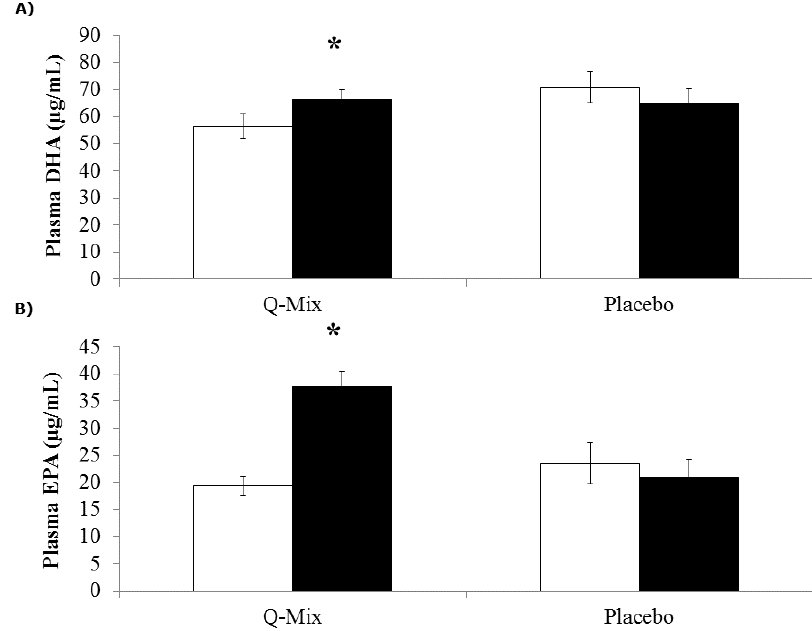
Figure 2. Plasma levels of n 3-PUFAs in participants who were randomly assigned to either placebo (0 mg/day of isoquercetin, EGCG, and n 3-PUFA) or Q-Mix (400 mg isoquercetin, 120 mg ECGC, and 400 mg n 3-PUFAs containing vitamin C and niacin). (A) * Plasma DHA levels increased with Q-Mix ( p < 0.001) from pre- ( ˝ ) to post- ( (cid:4) ) supplementation compared to placebo. Error bars represent SE. Significance test was based on two-way ANOVA (group and time); (B) * Plasma levels of EPA also increased with Q-Mix ( p < 0.001) from pre- ( ˝ ) to post- ( (cid:4) ) supplementation compared to placebo. Error bars represent SE. Significance test was based on two-way ANOVA (group and